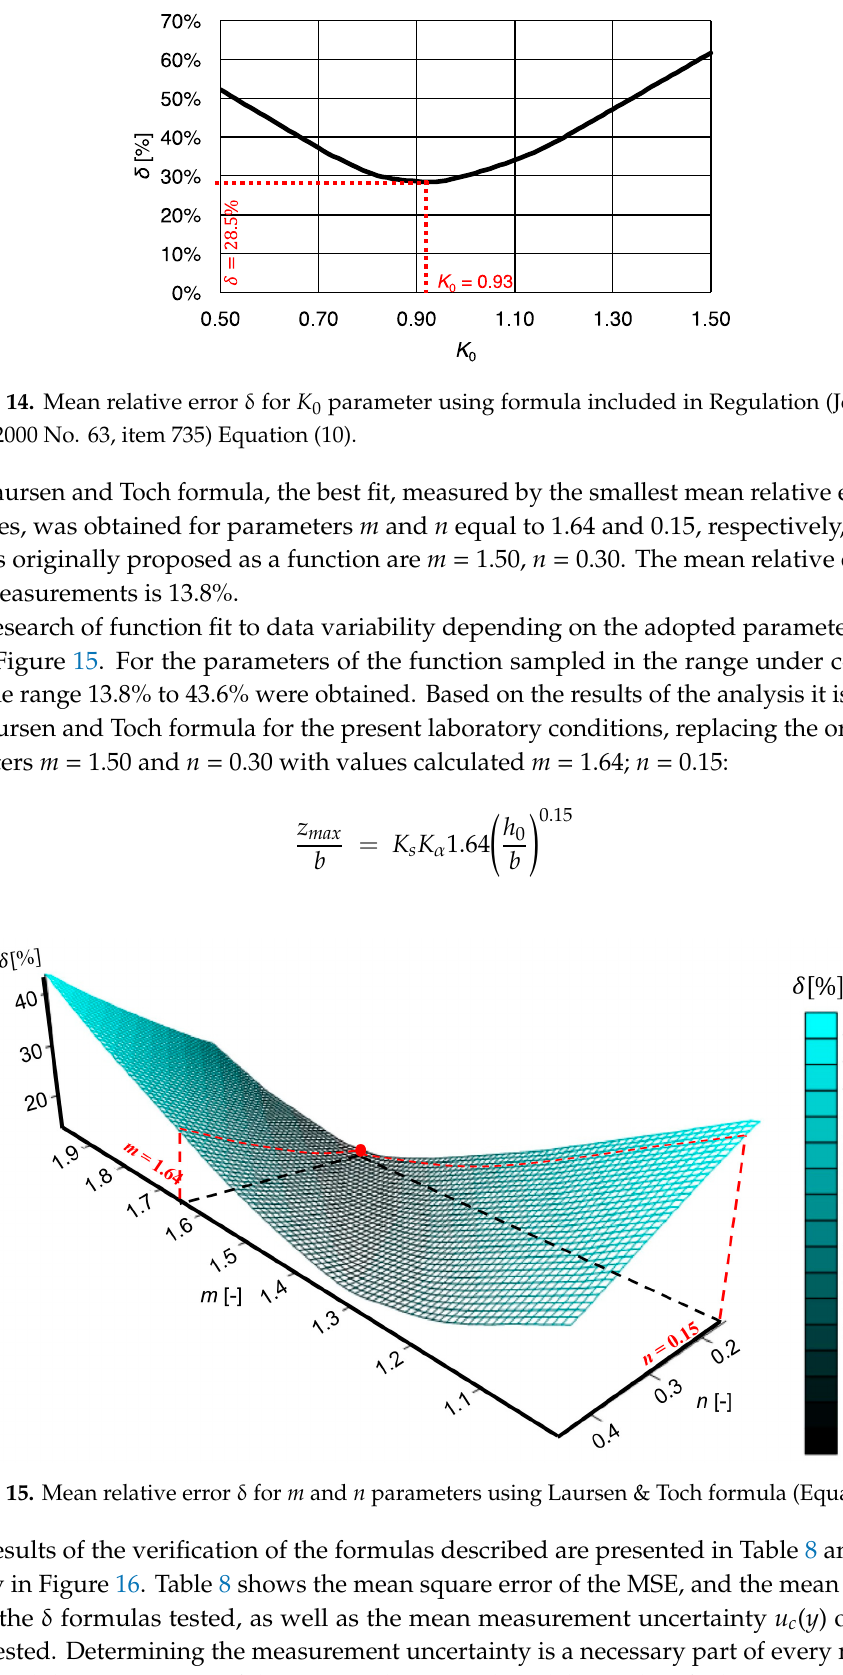
Figure 15. Mean relative error δ for m and n parameters using Laursen & Toch formula (Equation (9)).